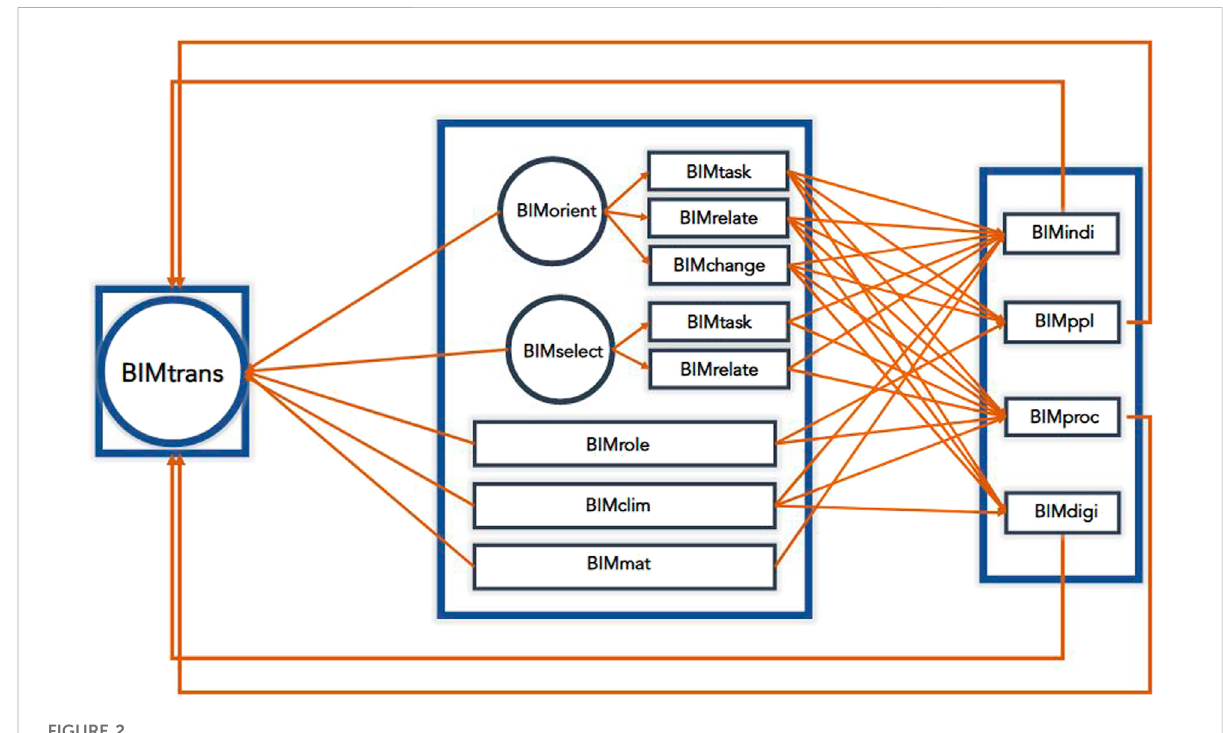
FIGURE 2 Hypothesised model of BIM leadership for organisational BIM